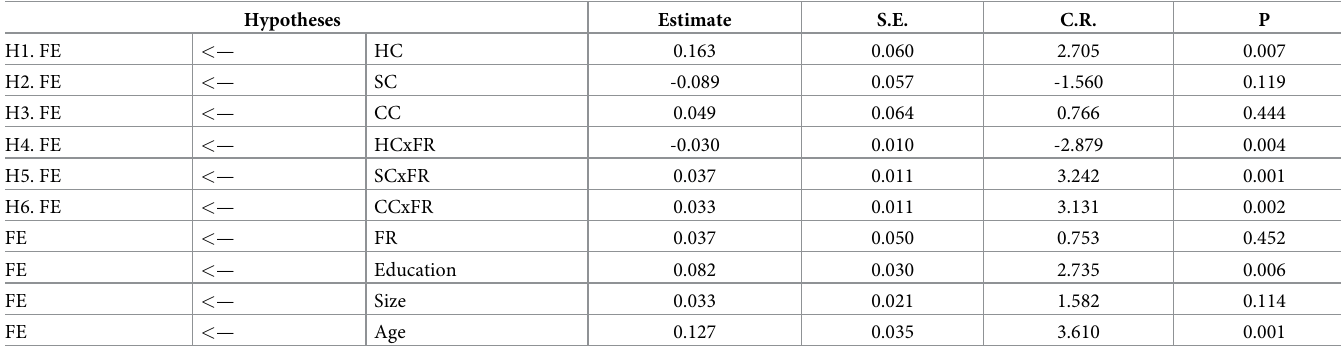
Table 5. Hypotheses